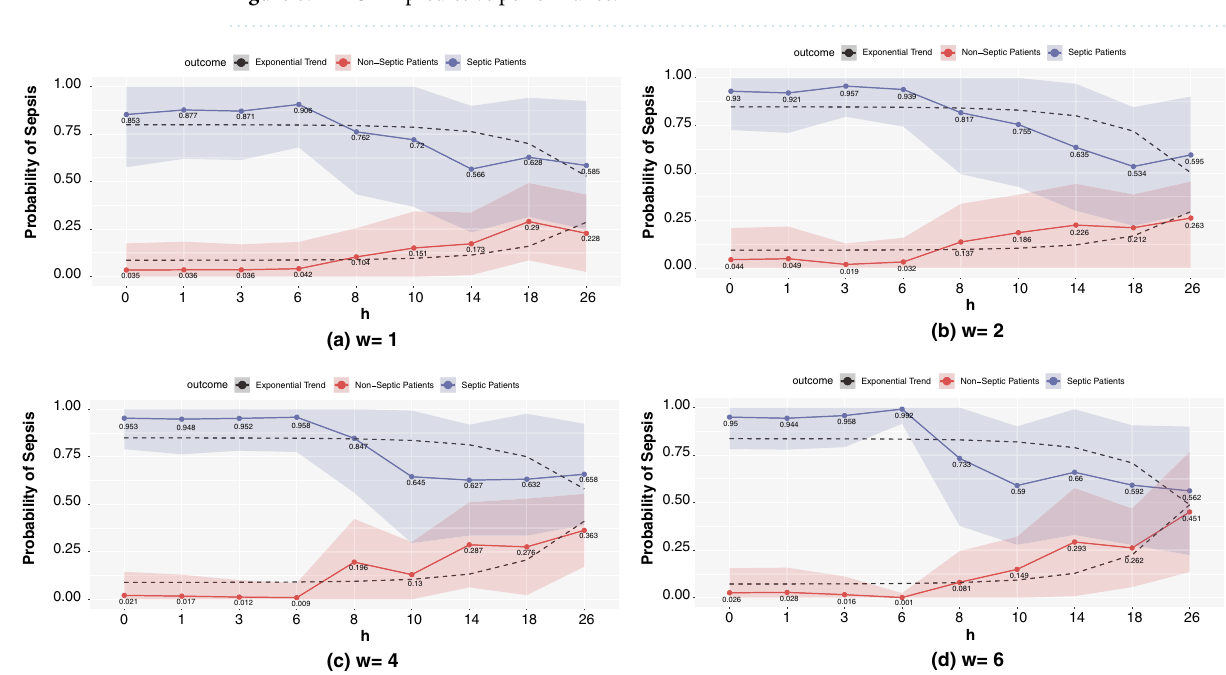
Figure 7. Predicted risk of sepsis among septic vs. non-septic